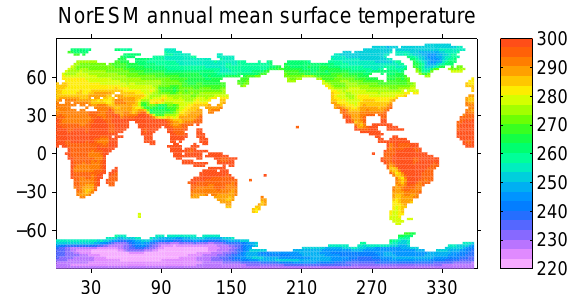
Fig. 16. Maps of annual mean surface temperature over land for years 1982–2005 as simulated by the NorESM. Units are in (K).